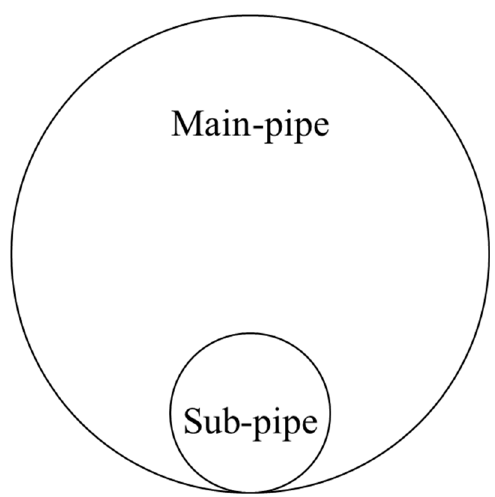
Figure 1. Classification of the sub-pipe for sewage and main pipe for